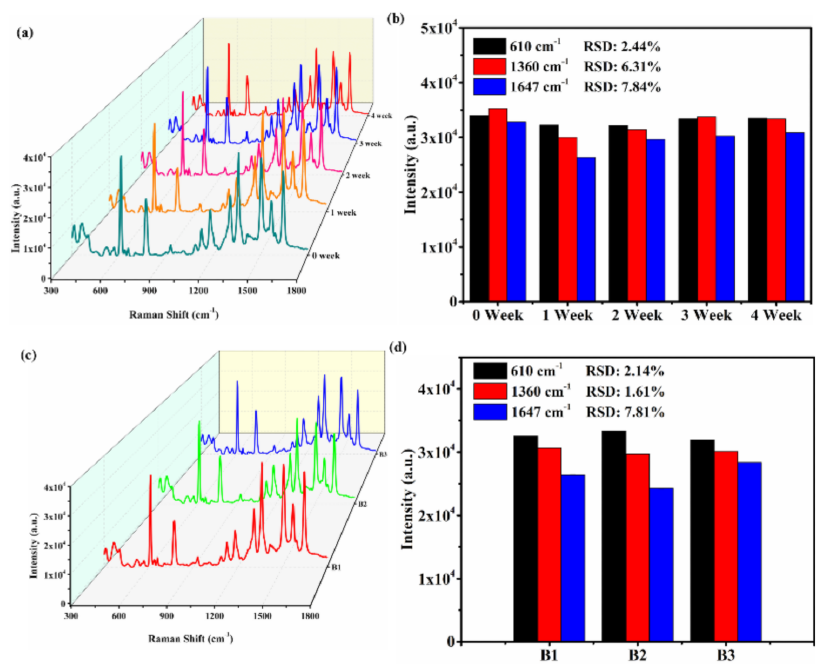
Figure 8. ( a ) SERS spectra of R6G (1 µ M) absorbed on PET-print-based SERS substrate with different storage times; ( b ) stability of PET-print-based SERS substrate. (Raman signals intensities of R6G at 610 cm − 1 , 1360 cm − 1 , and 1647 cm − 1 versus stored time; ( c ) SERS spectra of R6G (1 µ M) absorbed on PET-print-based SERS substrate fabricated using different batches of Ag inks; ( d ) reproducibility of PET-print-based SERS substrate. (Raman signals intensities of R6G at 610 cm − 1 , 1360 cm − 1 , and 1647 cm − 1 versus batch